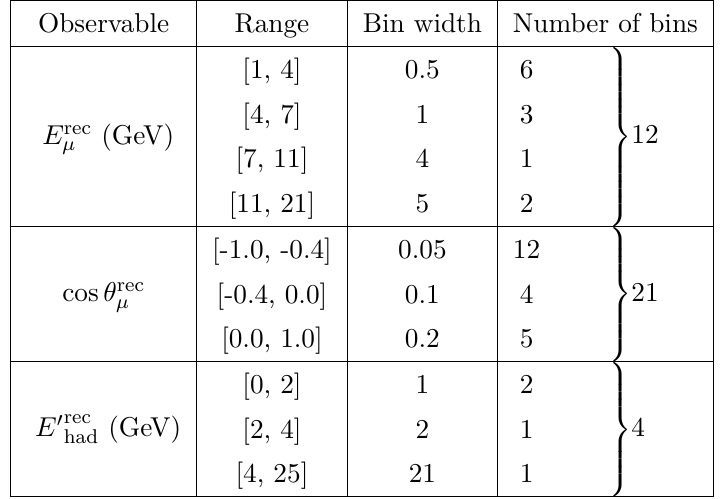
, cos θ rec , and E 0 rec for µ µ had